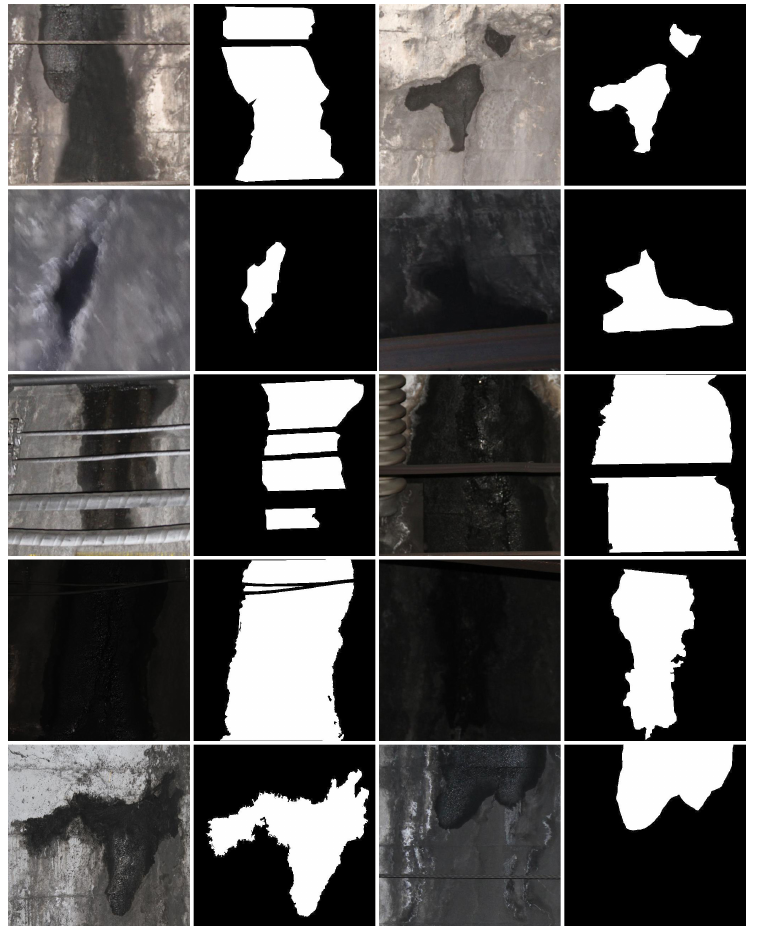
Figure 3. Representative images and ground truth of our rail tunnel leakage image